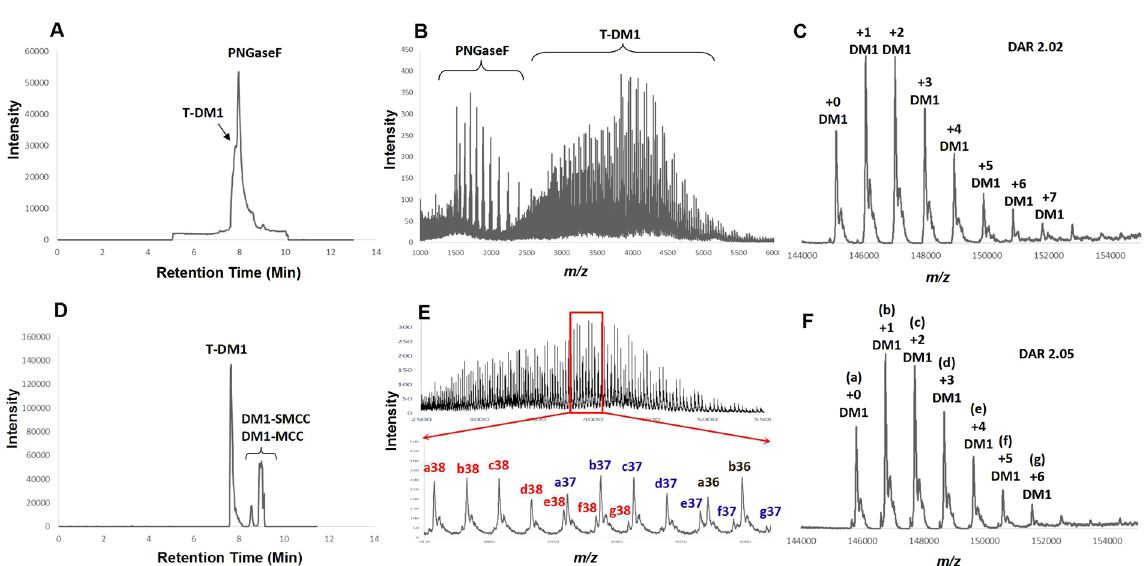
Figure 3. Comparison of LC-MS data of deglycosylated ADC 4 by PNGase-F and Endo-S. Total Ion Chromatograms (TIC) of T-DM1 ( 4 ) after deglycosylation with PNGase-F (Panel A) and Endo-S (Panel D); multi-charged m/z profiles of 4 after deglycosylation with PNGase-F (Panel B) and Endo-S (Panel E, upper: wide mass range 2500–5500; bottom: zoom-in mass range 3800–4100); deconvolution data and DAR calculation of 4 after deglycosylation with PNGase-F (Panel C) and Endo-S (Panel